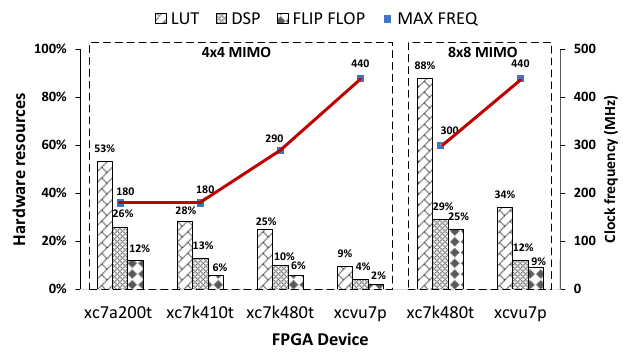
Figure 14. The EHSD resources utilization and maximum throughput frequency for (a) 4 × 4 and (b) 8 × 8 MIMO